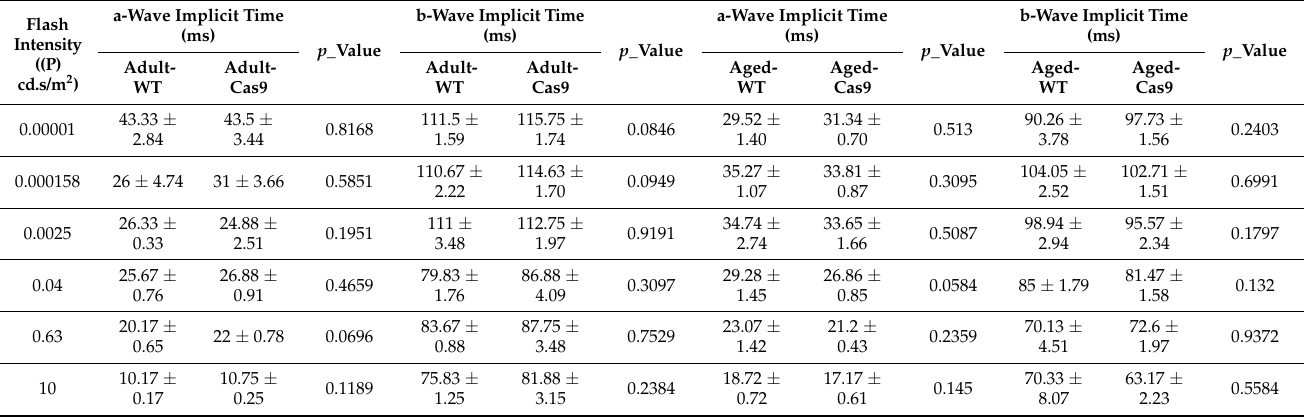
Table 2. The implicit times of a-wave and b-wave in adult and aged mice did not show significant difference between WT and Cas9